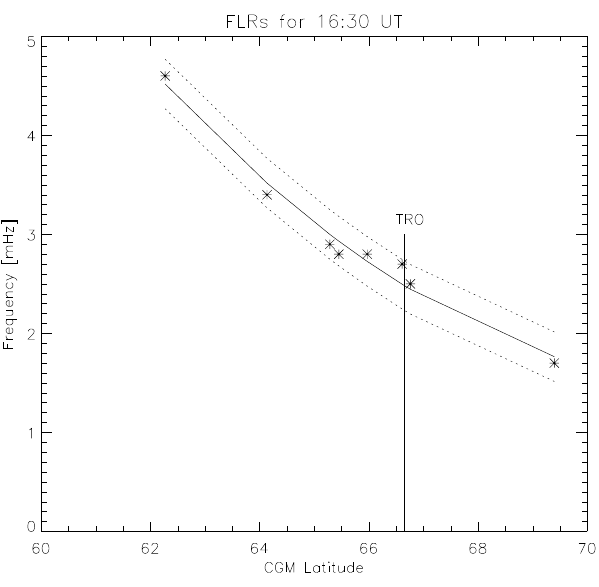
Fig. 3. Latitude variation of the FLR frequencies obtained from IMAGE magnetometer data for 16:00–18:00 UT, 25 March 2002 (see text for details). The latitude of the DOPE instrumentation is marked.